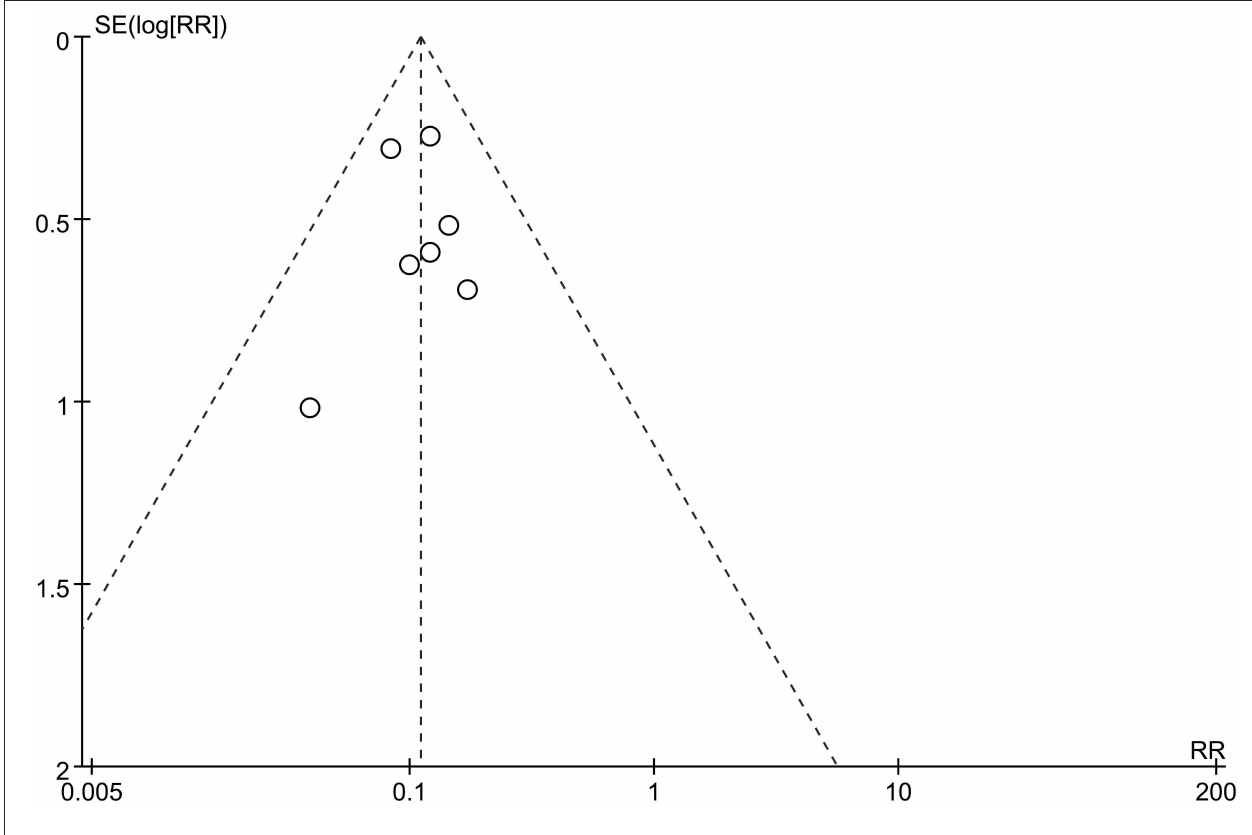
FIGURE 5 | Funnel plot of radiosurgery